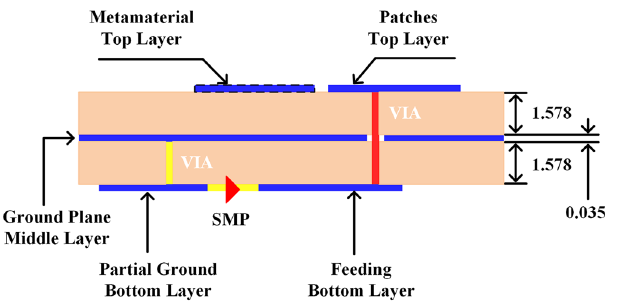
Figure 8. Stackup of the PCB board design displaying the